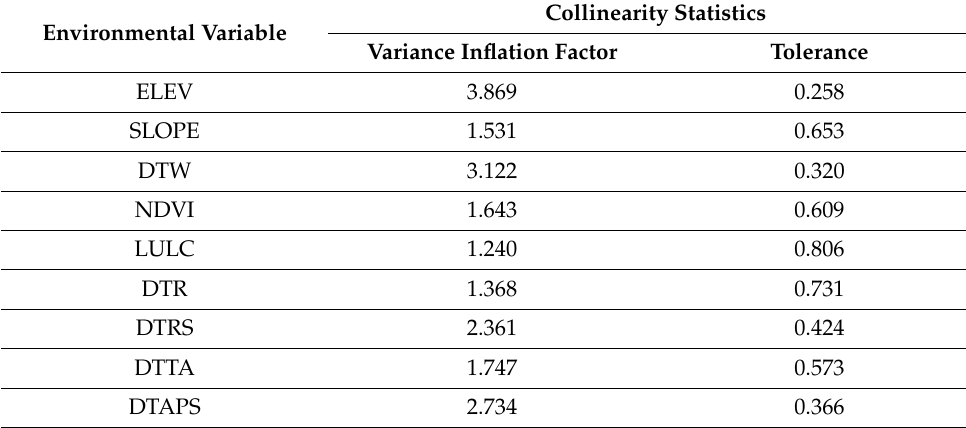
Table 5. Collinearity statistics of environmental